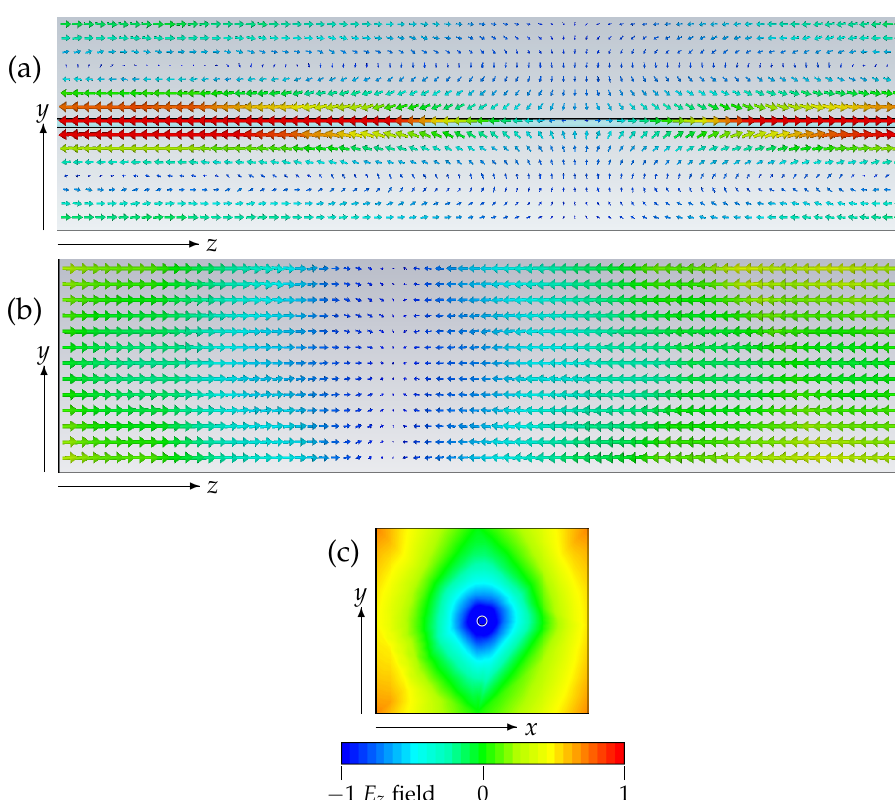
Figure 3. Numerical results showing a longitudinal mode in a infinite array of uniform infinitely long wires; as depicted in Figure 1a. The distances between the wires are given by L x = 15.0 mm and L y = 13.06 mm. The single period of the longitudinal electromagnetic wave is given by L z = 70.71 mm. We show a vector plot the electric field in the ( y , z ) plane ( a ) cut through the wires and ( b ) cut between the wires. In ( c ) we show the longitudinal component E z of the field in the ( x , y ) plane. Observe there is a region about the wire, roughly circular in shape, where this longitudinal component is approximately zero.